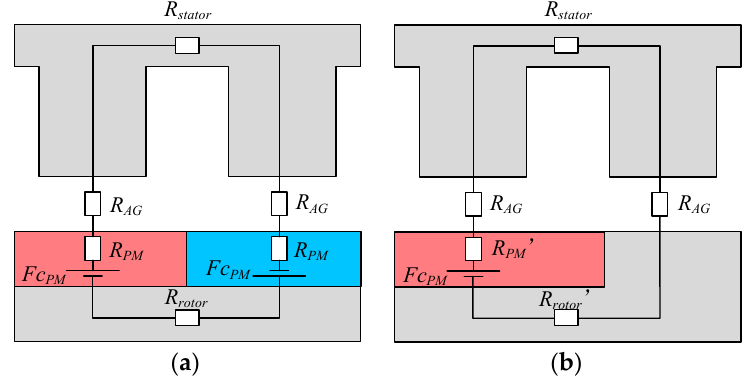
Figure 1. Flux circuit models for SPM and CPPM machines. ( a ) SPM. ( b ) CPPM.